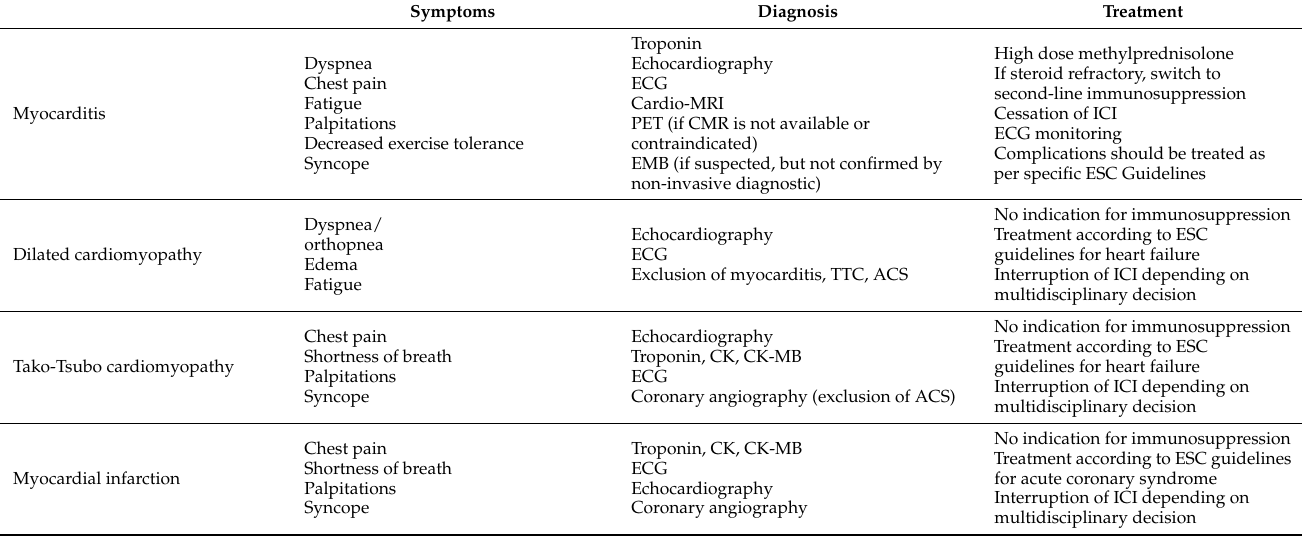
Table 2. Clinical symptoms, diagnostic and treatment management of ICI-associated myocarditis and cardiomyopathies